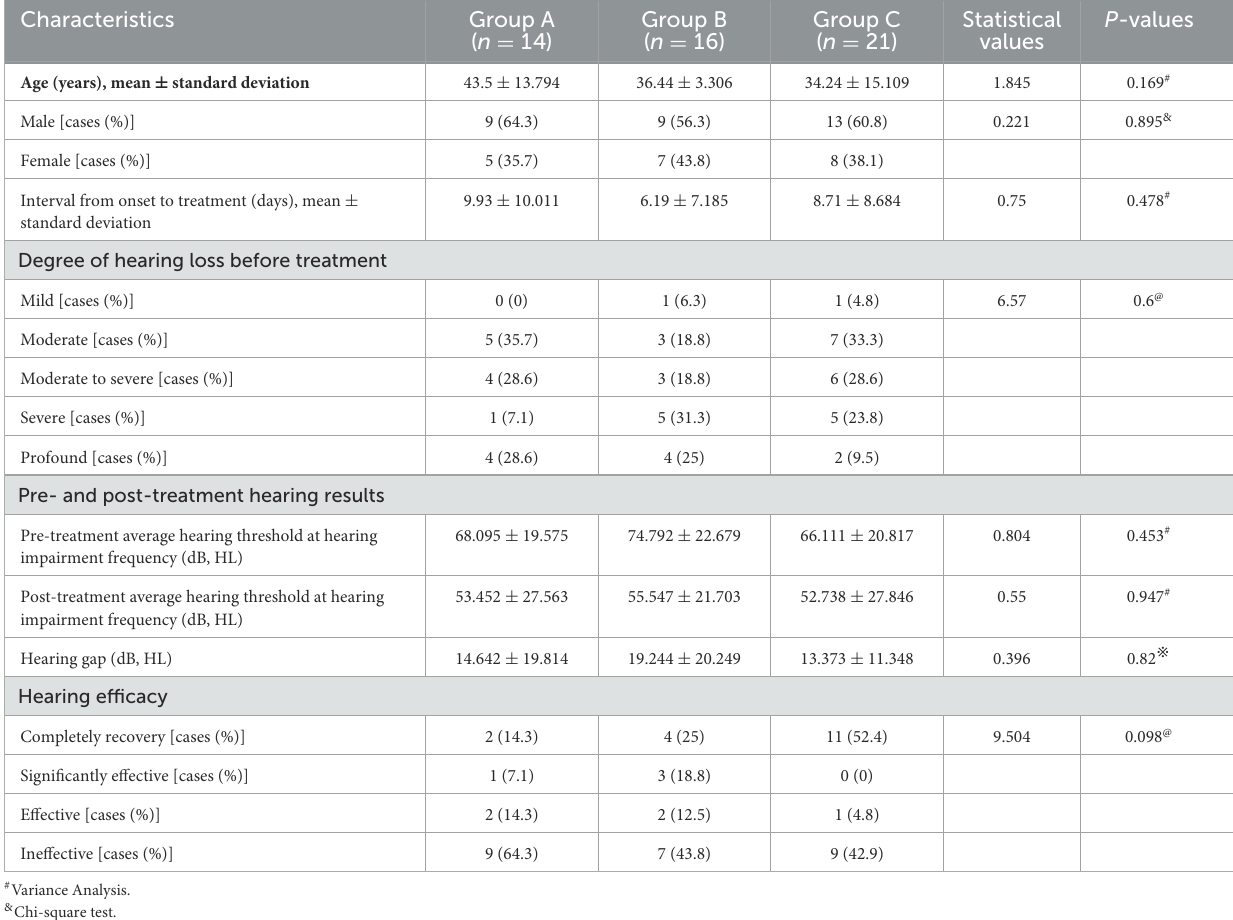
TABLE 5 Clinical characteristics and hearing efficacy of patients with descending-type SSNHL in the three groups. Characteristics Group A